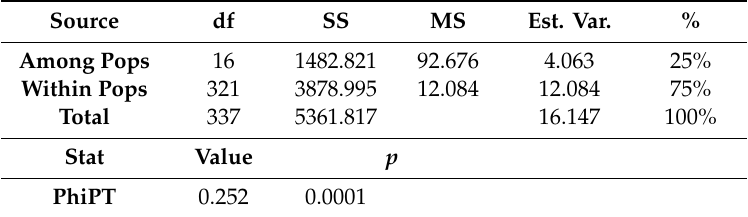
Table 4. AMOVA for all sampled populations with 9999 permutations. The majority of the variance associated with our data (75%) is found within the populations with the remainder (25%) found among the populations. There are significant di ff erences between populations ( p ≤ 0.0001) indicating a high level of genetic diversity. This is confirmed with a relatively high PhiPT (0.252) for all populations showing little similarity among